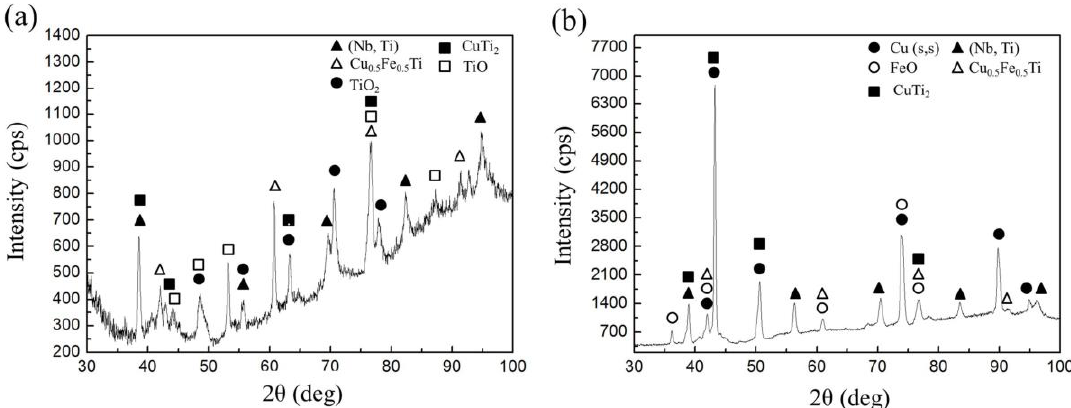
Figure 10. XRD patterns of fracture surface of welded joints at welding speeds of ( a ) 6 mm/s (EBW-1) and ( b ) 10 mm/s (EBW-3).